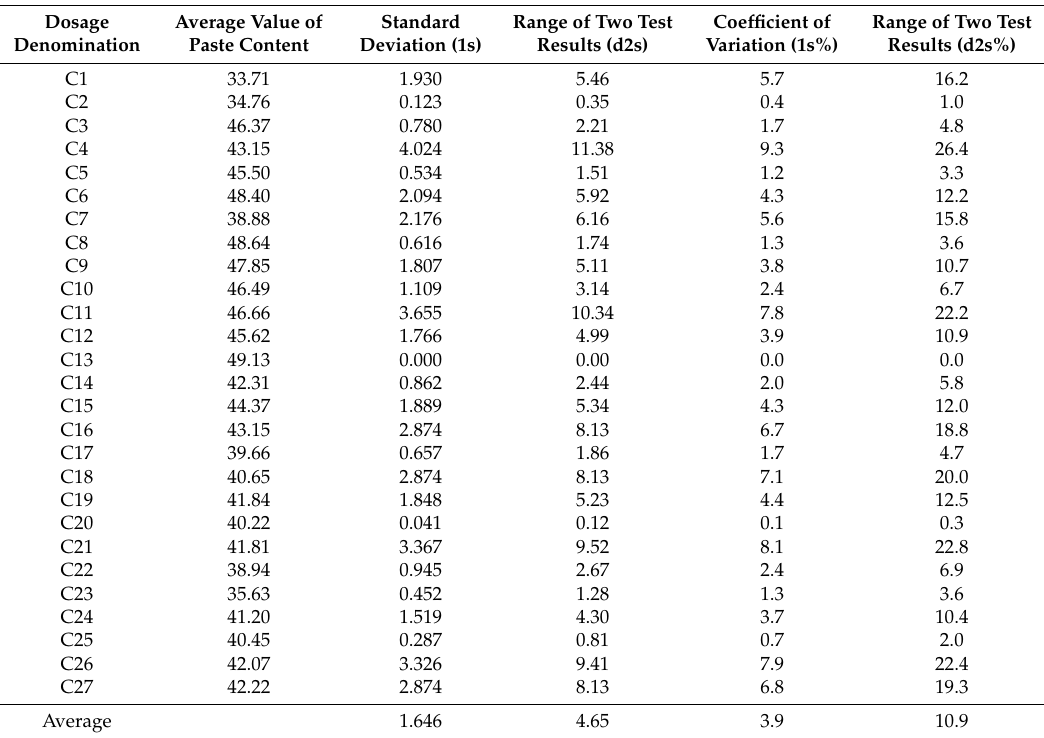
Table A4. Average value and dispersion data of the paste content (%) of the 27 dosages (two slabs per